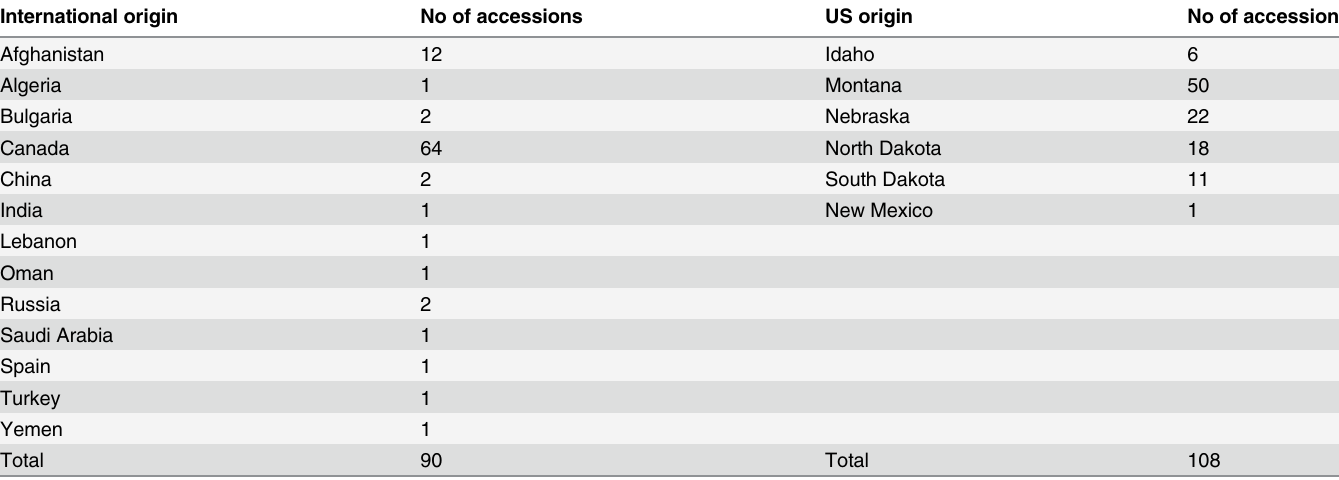
Table 1. Origins and number of accessions of alfalfa germplasm used in the drought tolerance analysis. International